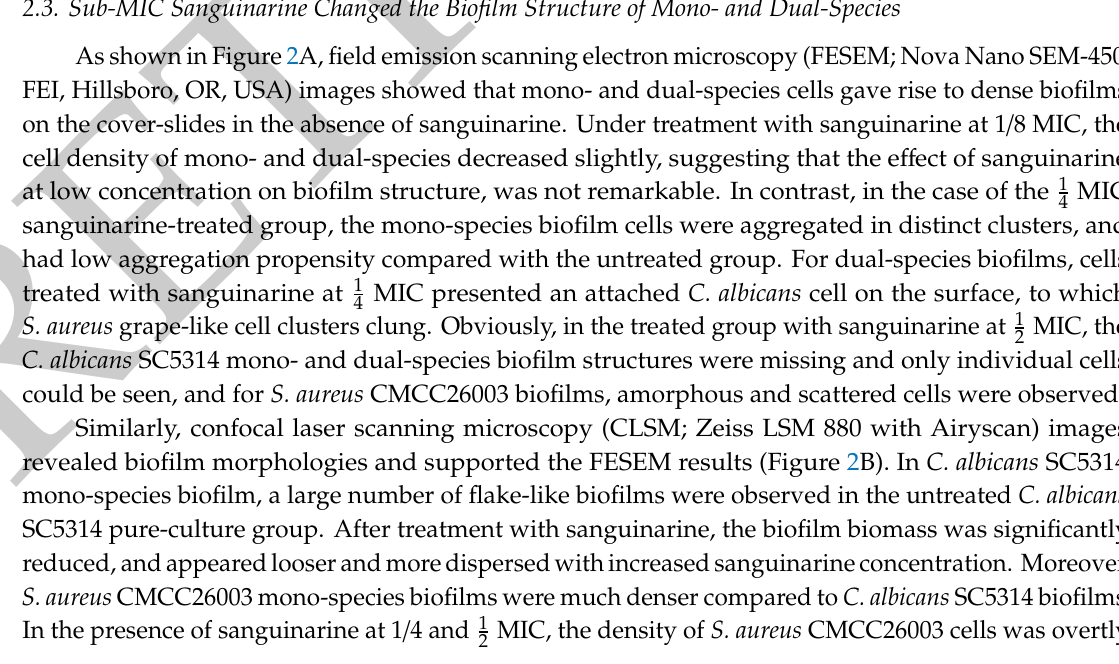
Figure 1. Inhibitory effects of different concentrations of sanguinarine on C. albicans SC5314 and S. aureus CMCC26003 mono- and dual-species biofilms by the crystal violet assay. Values represent the means of triplicate measurements. Bars represent the standard deviation (N = 6). * p < 0.05; ** p < 0.01; *** p < 0.001; NS, not significant.